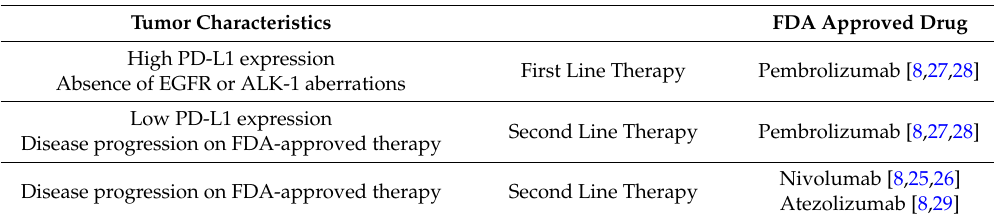
Table 2. Immunotherapy for